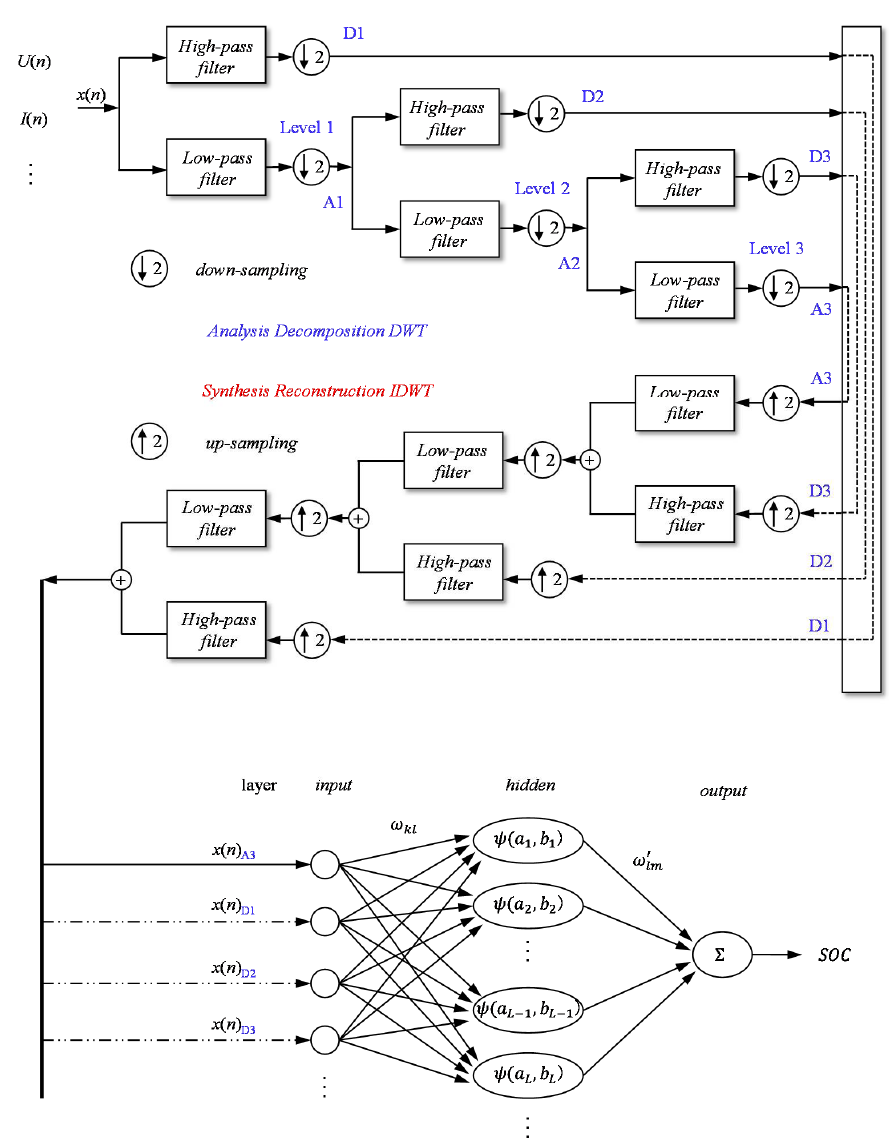
Figure 2. Structure of a three-level, DWT-based decomposition and reconstruction processes and DWT-WNN-based SOC estimation process.